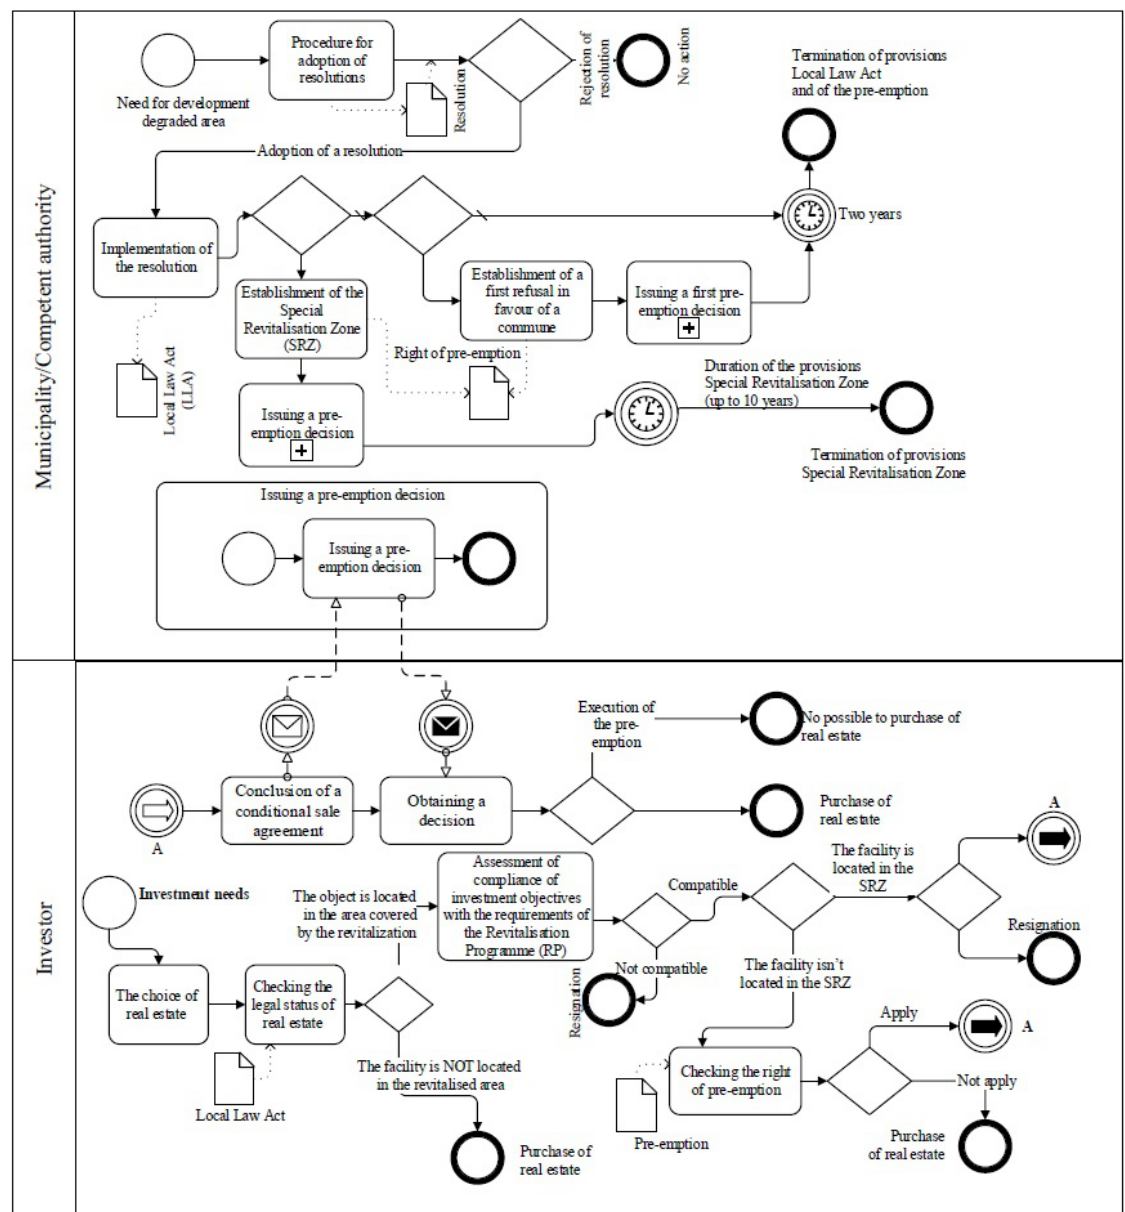
Figure 1: Acquisition of real estate in the area covered by revitalisation (own elaboration based on [10]